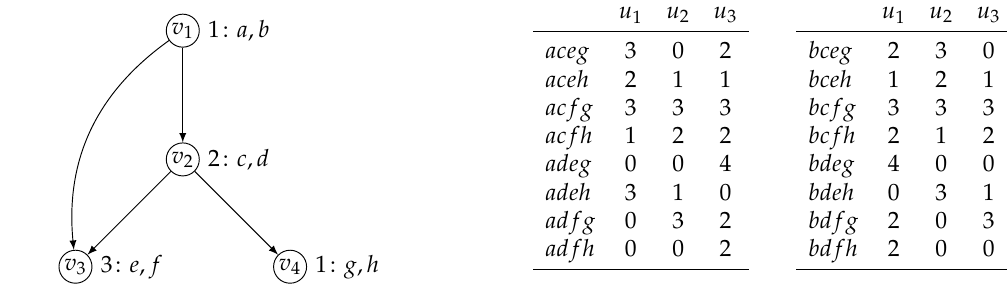
Figure 3. A simple example of a partial order game. On the left, the DAG, where each vertex v is labelled i : x , y , where i is the player active at the respective vertex and x and y are the actions available to i at v . On the right, the representation of the utility function which associates a numeric value with each action profile.